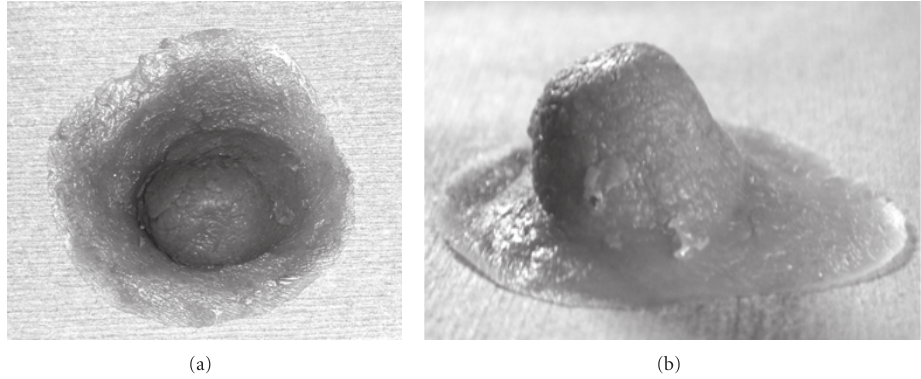
Figure 4: nipple-areolar complex made with silicon